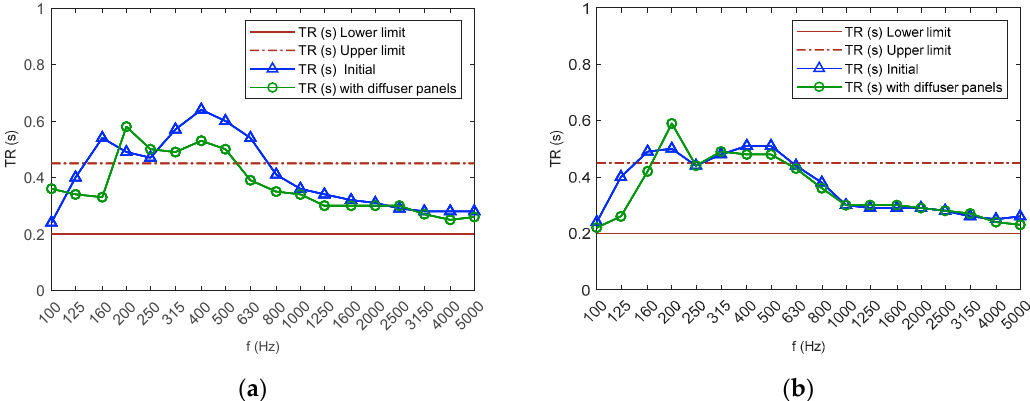
Figure 2. Reverberation time (TR) for source and receiving rooms: ( a ) source room; ( b ) receiving room.